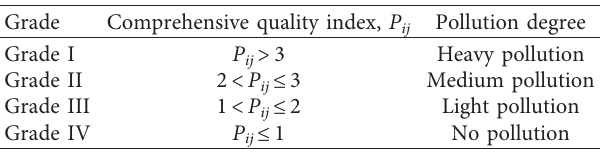
Table 2: Grades for the comprehensive quality index ( P ation of heavy metals in marine living